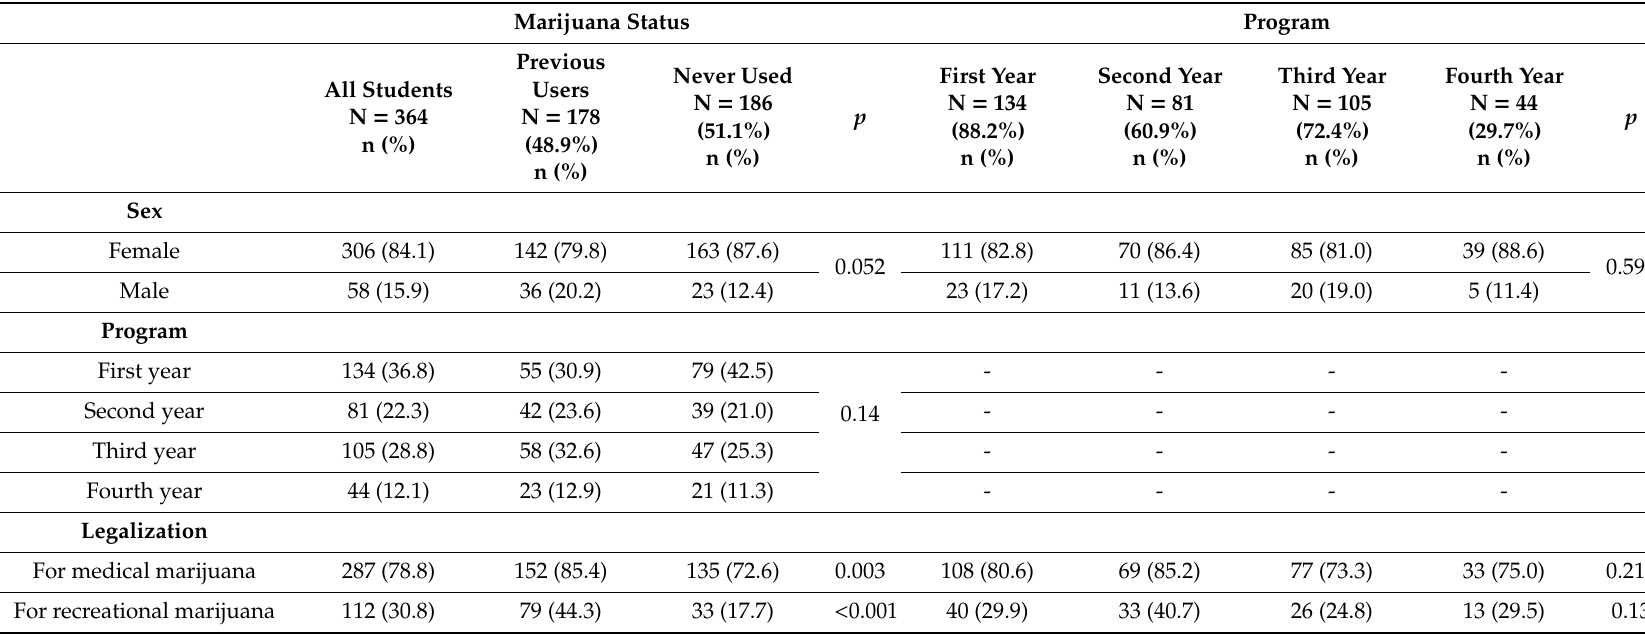
Table 1. Demographic and other characteristics of nursing students. Statistical significance ( p < 0.05) was determined by chi-square